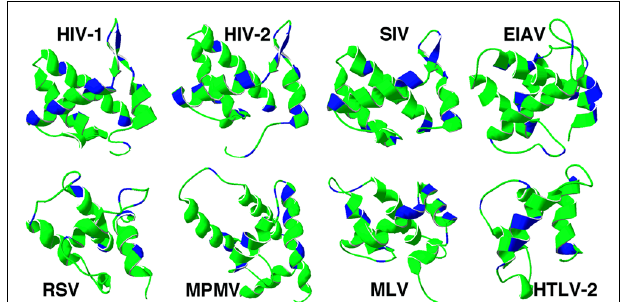
FIGURE 1 | Retrovirus matrix protein membrane binding regions. Ribbon diagrams of the membrane binding regions of four lentivirus matrix proteins (top row) and an alpharetrovirus (RSV), betaretrovirus (MPMV), gammaretrovirus (MLV), and deltaretrovirus (HTLV-2) are depicted. In each case, matrix helix one is on the right-hand side of the figure, and basic residues are indicated in blue.The PDB files for each matrix protein are as follows: HIV-1 (1UPH), HIV-2 (2K4H), SIV (1ECW), EIAV (1HEK), RSV (1A6S), MPMV (1BAX), MLV (1MN8), HTLV-2 (1JVR).